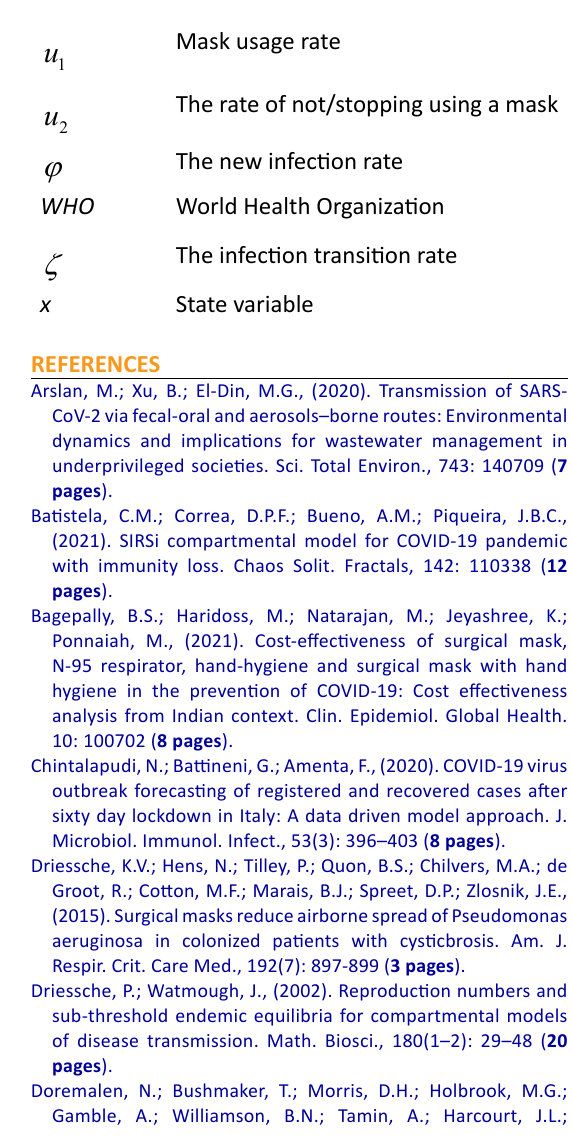
Fig. Figure The rate of quarantine individuals γ recovers with treatment Identity matrix Number of subpopulations of infect - I ed individuals not wearing masks 1 Number of subpopulations of infect - ed individuals wearing masks